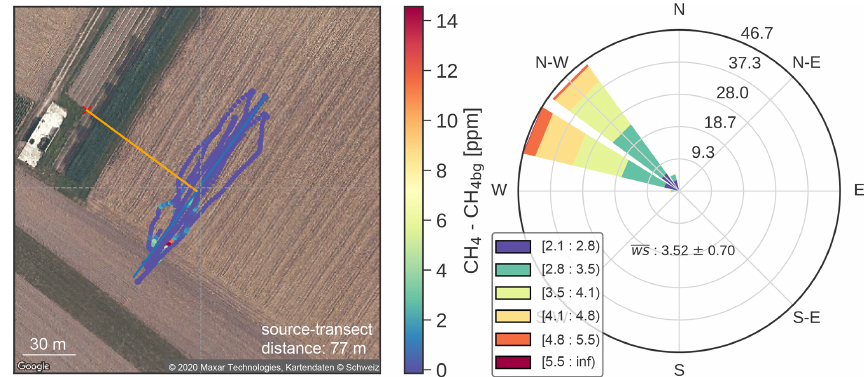
Figure 3. Measured methane mole fraction above background during MATRIX with flight code 312_03 and its corresponding wind rose. The red cross indicates the location of the artificial source. The source transect distance, shown as the orange line, is computed as the perpendicular distance between the source and the measurement plane. The flight trajectories are illustrated as coloured dots, indicating the measured local CH 4 concentrations. Wind and turbulence conditions are measured with a 3D sonic anemometer located next to the